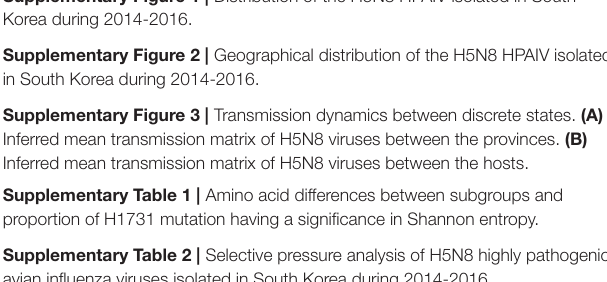
Supplementary Figure 1 | Distribution of the H5N8 HPAIV isolated in South Korea during 2014-2016. Supplementary Figure 2 | Geographical distribution of the H5N8 HPAIV isolated in South Korea during 2014-2016. Supplementary Figure 3 | Transmission dynamics between discrete states. (A) Inferred mean transmission matrix of H5N8 viruses between the provinces. (B) Inferred mean transmission matrix of H5N8 viruses between the